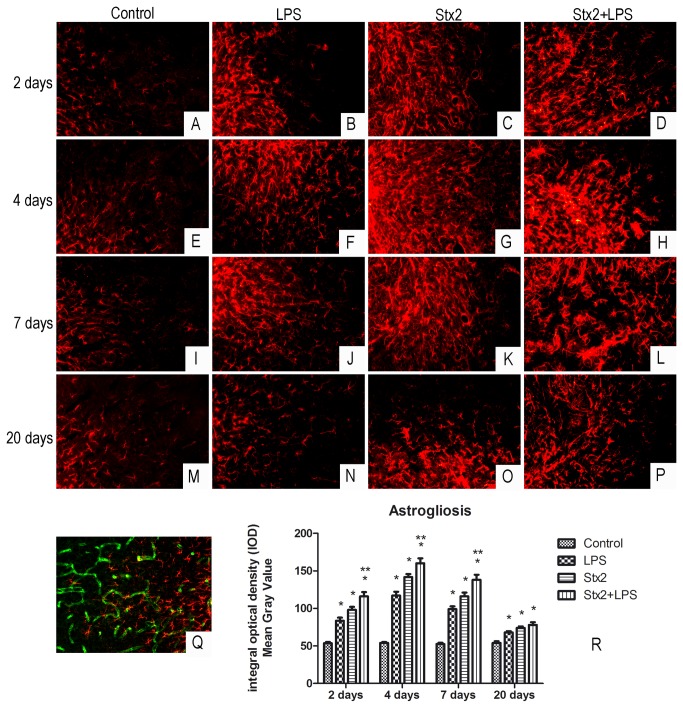
A sub-lethal dose of the toxins causes reactive astrocytes.Immunofluorescence using an anti-GFAP antibody was employed to show reactive astrocytes in mice motor cortex. A, E, I and M: saline-treated astrocytes; B, F, J and N: LPS-treated astrocytes; C, G, K and O: Stx2-treated astrocytes; D, H, L and P: Stx2+LPS-treated astrocytes; at two, four, seven and twenty days after the respective treatment. Some reactive astrocytes contact microvessels that express VEGF (Q). Quantification of reactive astrocytes (R). Stx2+LPS treatment caused maximum astrocyte reaction (H). *: significant differences between toxin-treated and control groups, **: significant differences between Stx2 and Stx2+LPS treatments (p <0.001).